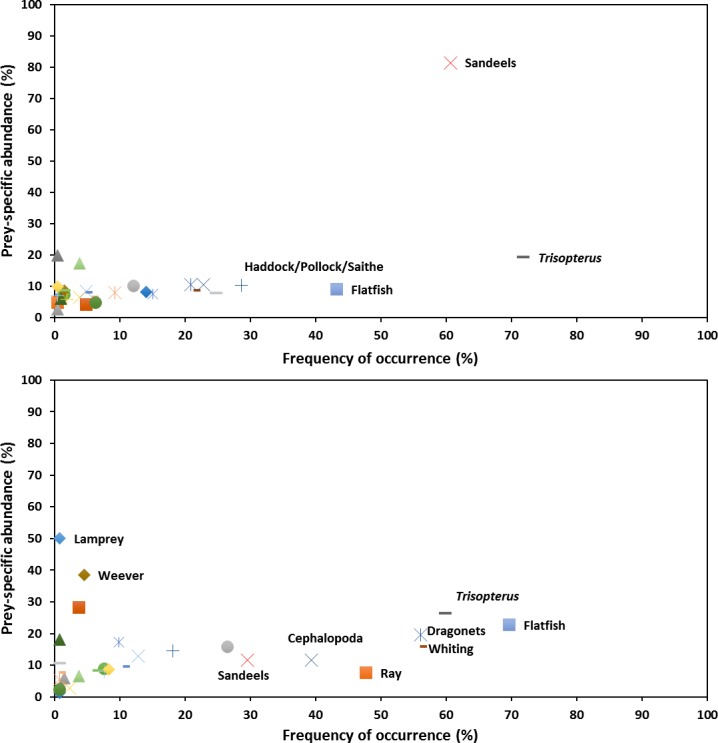
Modified Costello-Amundsen plots.Plots of all prey in terms of their occurrence and importance by number for GBI (upper frame) and WH (lower frame). Species occurring in the upper left represent prey that were consumed rarely, but when they were consumed, accounted for a large proportion of the predators’ diet. Species in the lower left denote prey that occurred rarely and were of relatively low importance to the overall diet. Species occurring in the upper right represent important prey found within the majority of diet samples that also accounted for a large part of the total diet. Finally, despite occurring in high frequencies, those prey species located towards the lower right corner of the diagram, only made a small contribution to the diet.